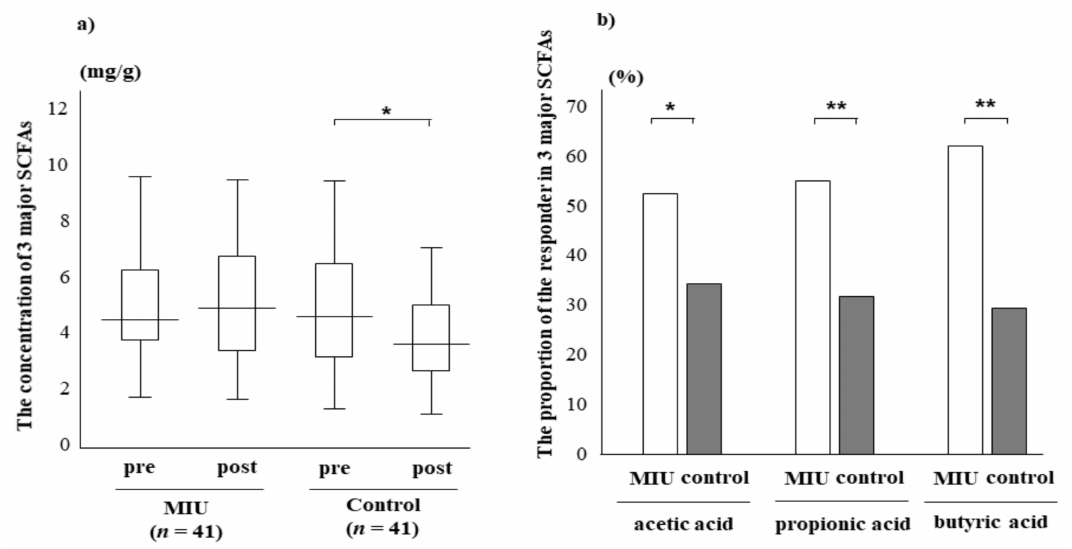
Figure 3. Effect of MIU or control water on fecal biomarker concentrations of 3 SCFAs (acetic acid, propionic acid, and butyric acid) throughout the intervention period. ( a ) The concentrations of the SCFAs decreased in the control group (* p < 0.1). There was a 23% difference between the 2 groups. The top and bottom of each box indicate the 25th and 75th percentiles, and the solid line within the box is a median. Whiskers depict the minimum and maximum values. pre, preintervention; post, postintervention, ( b ) The proportions of responders were significantly higher in the MIU group than in the control group. * p < 0.05; ** p <